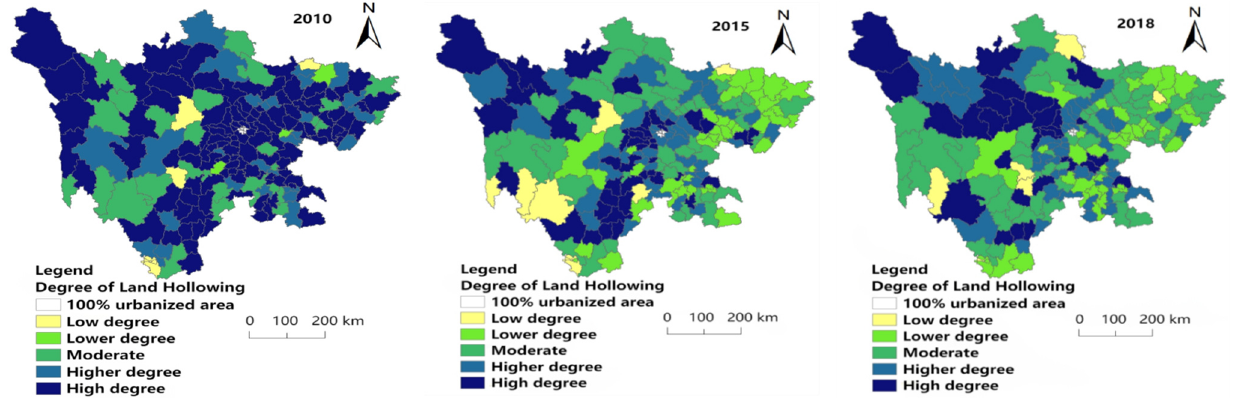
Figure 4. Spatial distribution of land hollowing degree in 2010, 2015 and 2018.